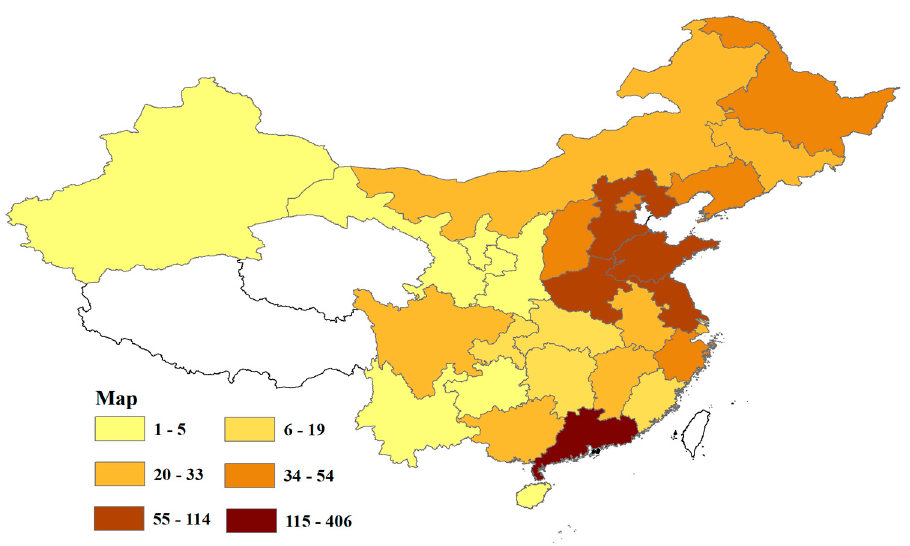
Figure 2. Map of the distribution of participants’ regions of origin across China.